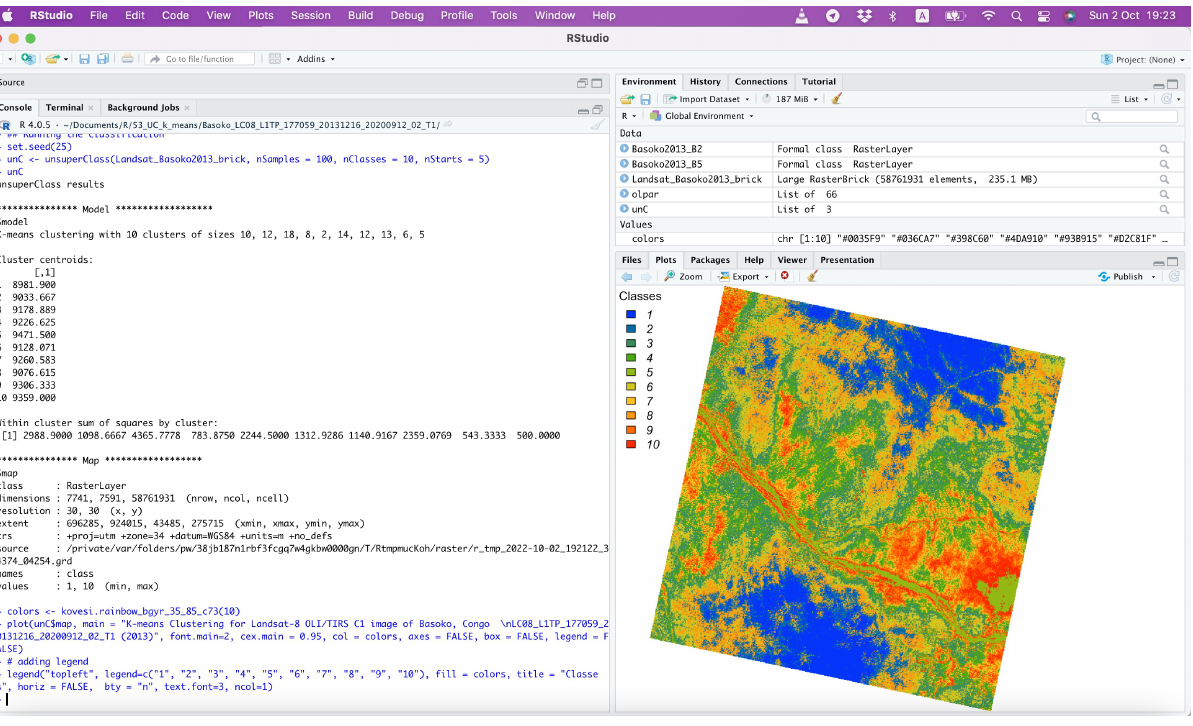
Figure 6. Executing the k-means clustering classification algorithm in RStudio using the RStoolbox package. Parameters of cluster centroids and sum of squares by cluster are displayed in the console of R. Spatial parameters of the output map are listed. Here is shown the example of Landsat image of